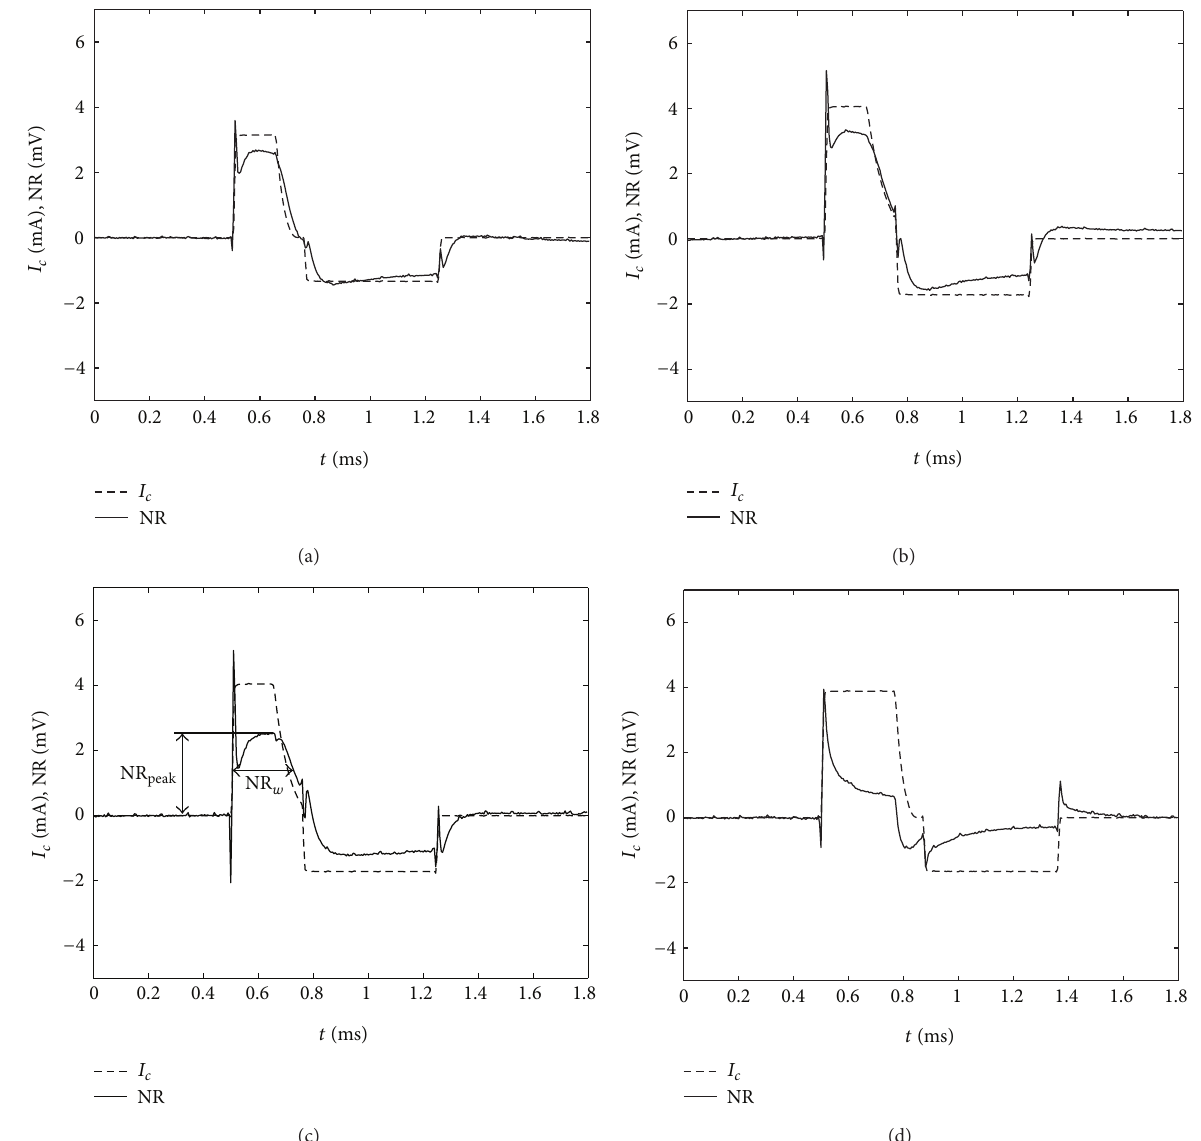
Figure 4: Examples of preset stimulus waveforms and the proprietary NR. Solid line represents stimulating intensity and dashed line represents neural response NR. NR peak is obtained at the top of the bell-shaped NR in the cathodic phase of the stimulus; NR 𝑤 is made at 50% of NR peak